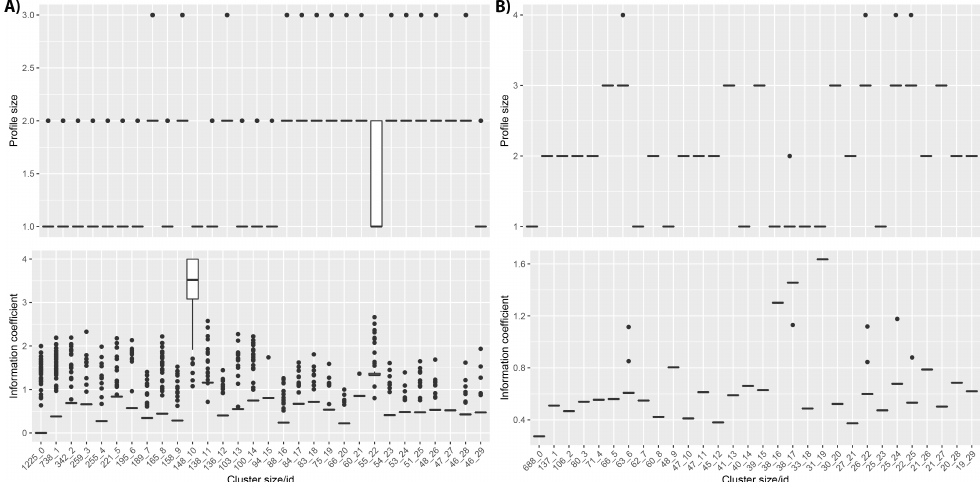
Figure 5. Information content (IC) distribution for the top 30 clusters obtained using Naïve clustering. Upper panels: HPO profile size for each cluster. Lower panels: IC distribution. ( A ) DECIPHER and ( B )